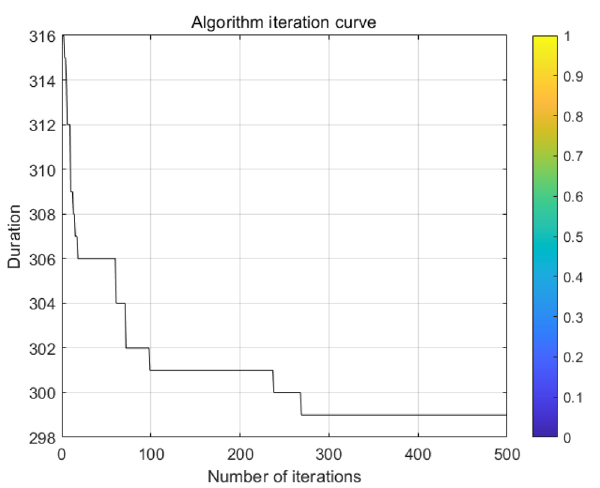
Figure 9. Duration iteration.